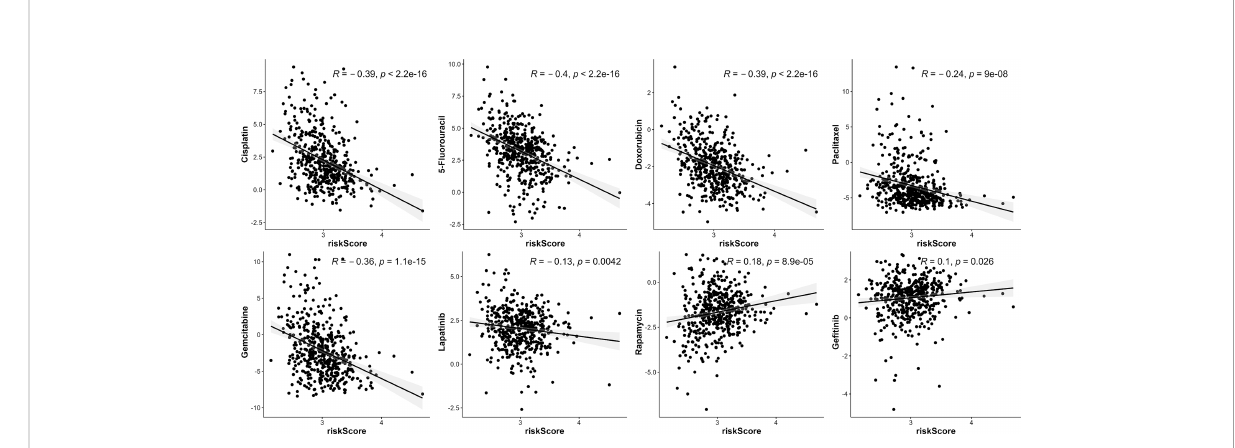
FIGURE 10 The association between risk score and drug sensitivity. VMTRG risk score was correlated with Cisplatin, 5-Fluorouracil, Doxorubicin, Paclitaxel, Gemcitabine, Lapatinib, Rapamycin, Ge fi tinib drug sensitivity (IC50) in the